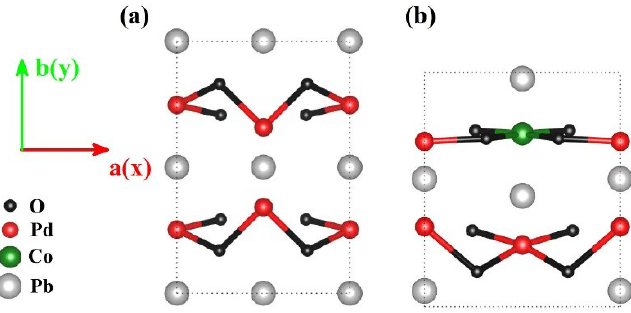
Figure 1. Top view of atomic structures in ab plane, ( a ) PbPdO 2 , and ( b ) PbPd 0.75 Co 0.25 O 2 with (002) orientation.